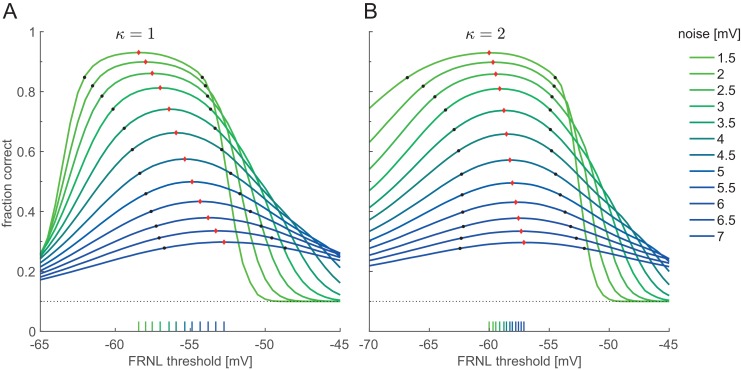
Dependence of the optimal threshold on the level of membrane potential noise.Linear decoding performance is measured at various FRNL threshold levels with a threshold-linear nonlinearity (κ = 1, (A) and with a threshold quadratic nonlinearity (κ = 2, (B). As the amplitude of membrane potential noise increases, the optimal threshold progressively shifts to higher values (red diamonds and corresponding ticks on the x axis). Black dots indicate the minimum and maximum of the FRNL threshold range in which decoding performance exceeds the 9% of the performance measured at the optimal threshold.